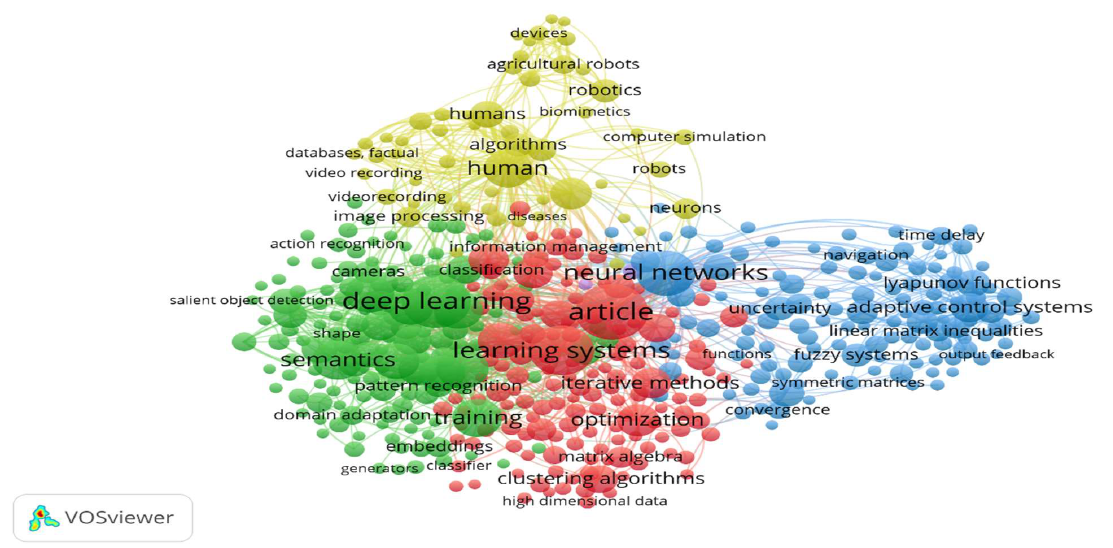
Figure 3. Co-occurrence of author-specified keywords appearing at least 30 times in the leading AI journals publications during 2020 and 2021. journals publications during 2020 and